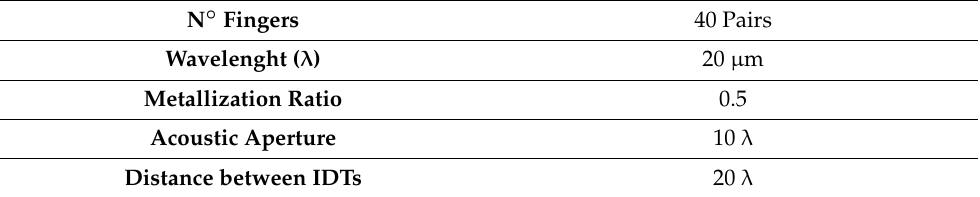
Table 1. Design parameters of the IDT electrode of SAW fabricated